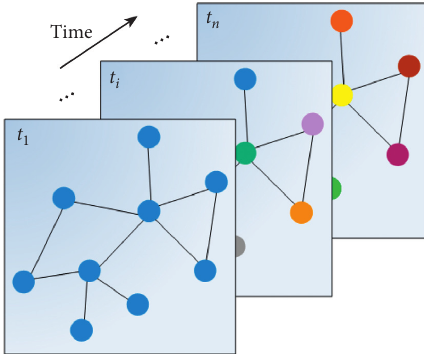
Figure 5: Traffic flow data with graph structure at different